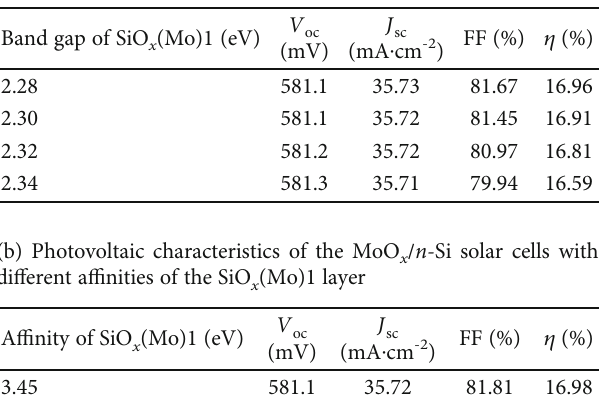
(a) Photovoltaic characteristics of the MoO di ff erent band gaps of the SiO Band gap of SiO